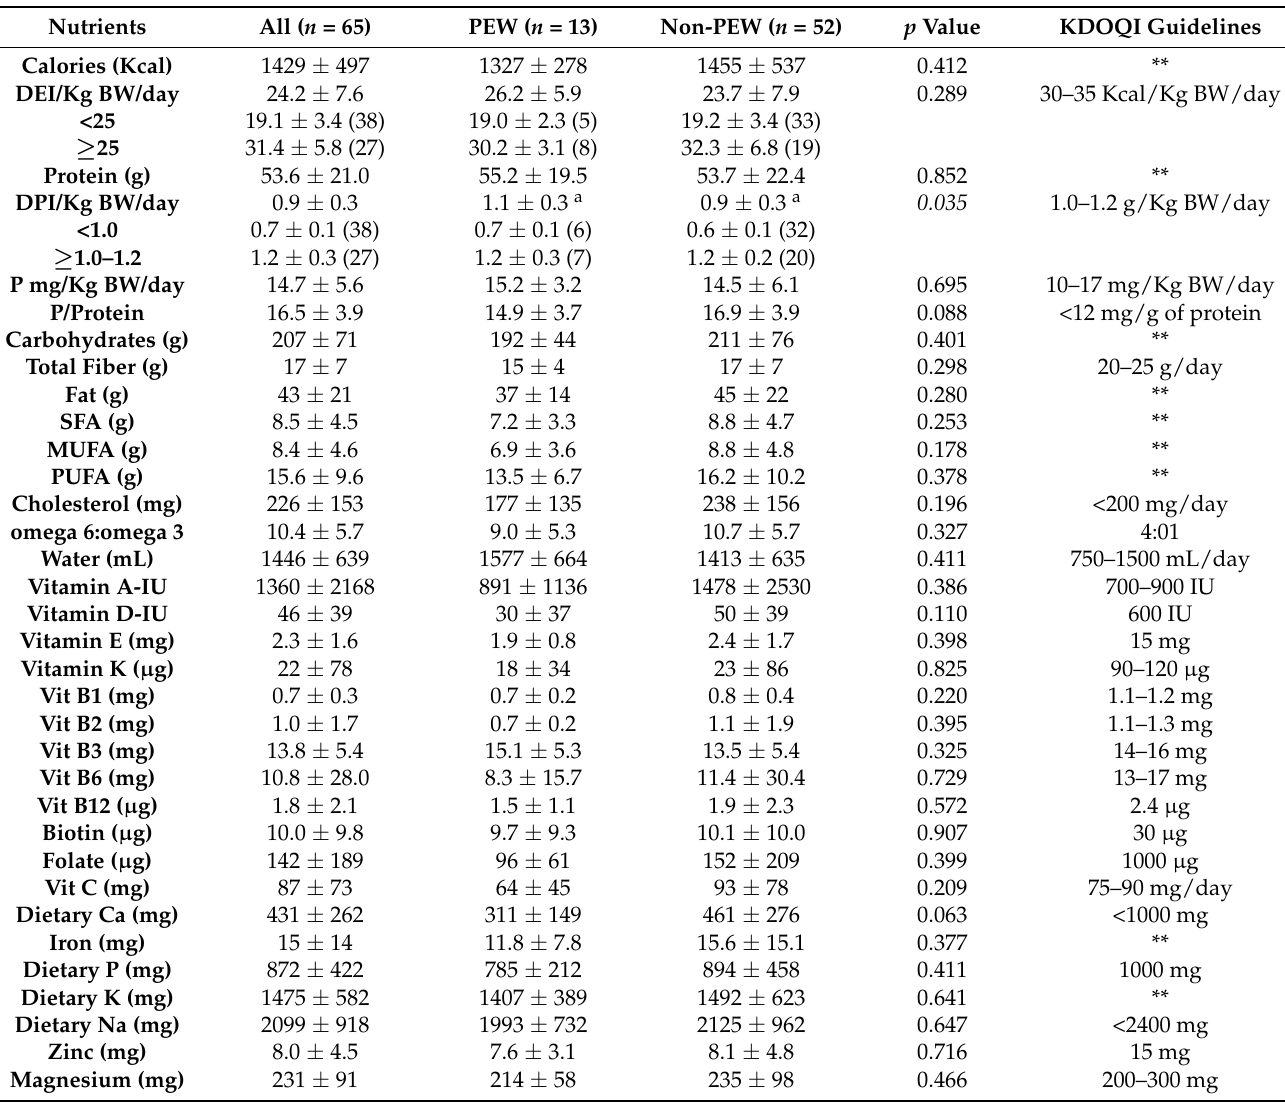
Table 2. Dietary analysis for acceptable reporters between PEW and Non-PEW